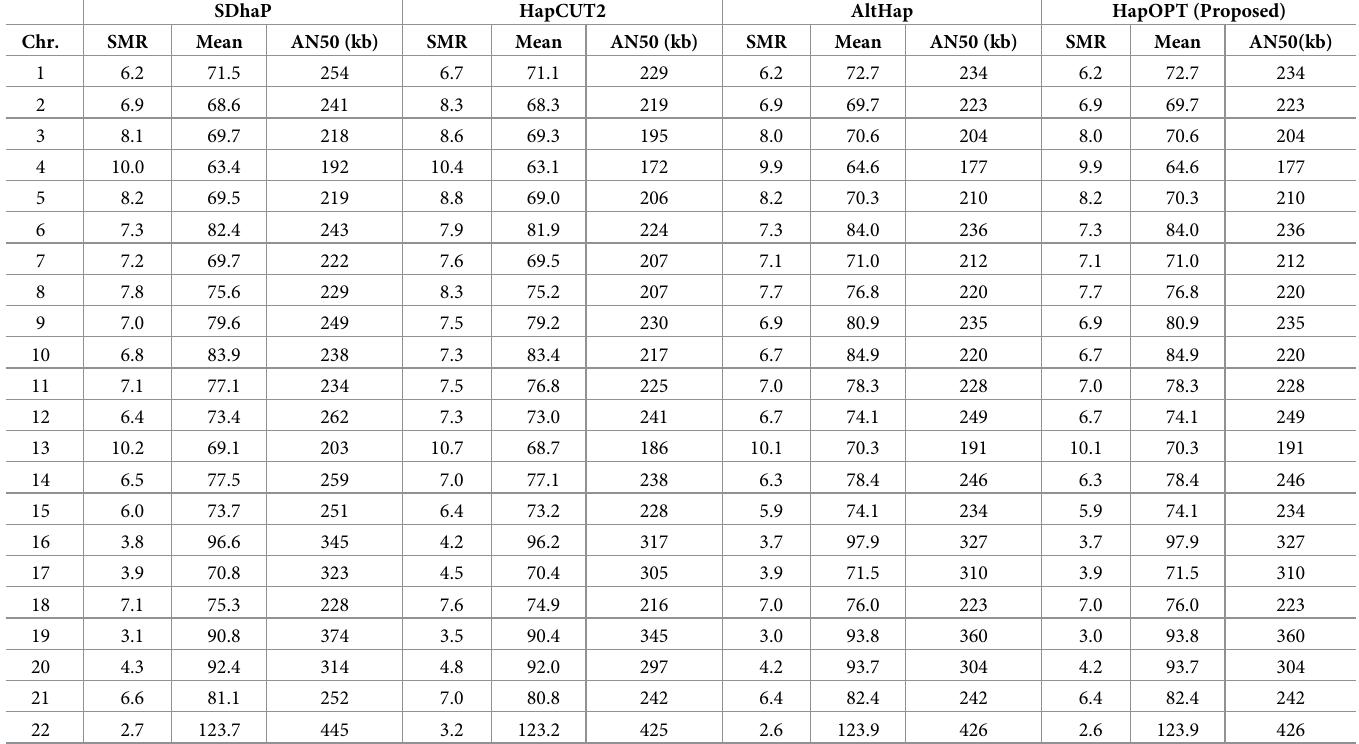
Table 5. Mean and AN50 of haplotype blocks lengths for different algorithms on real fosmid data. SDhaP HapCUT2 AltHap